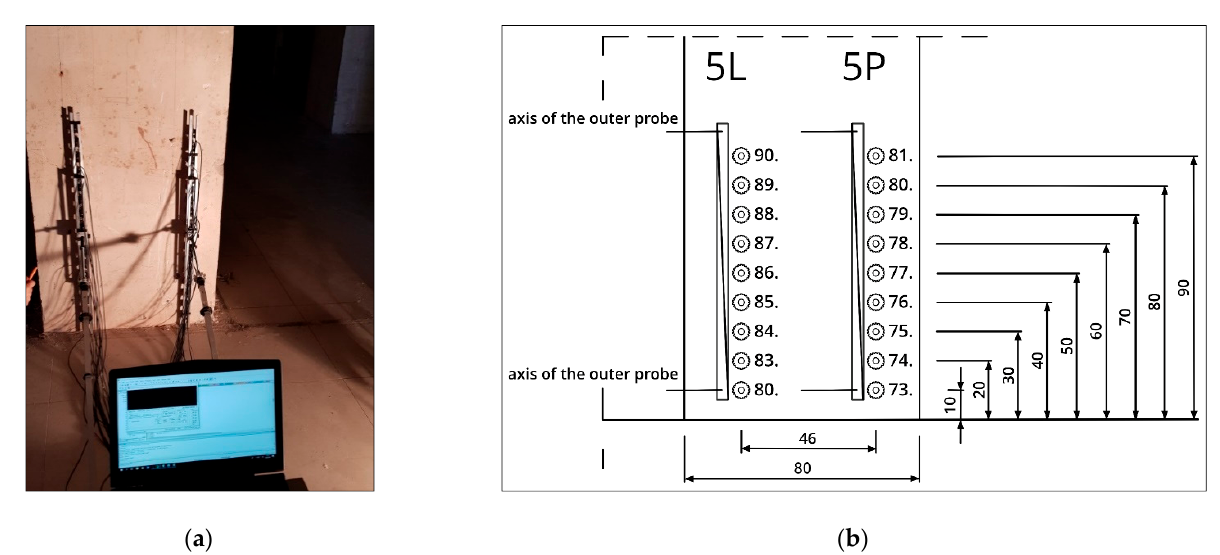
Figure 11. Moisture tests of an internal brick pillar: ( a ) view of the pillar with the EIT electrodes applied; ( b ) distribution of measurement points for comparative dielectric, microwave and gravimetric methods.